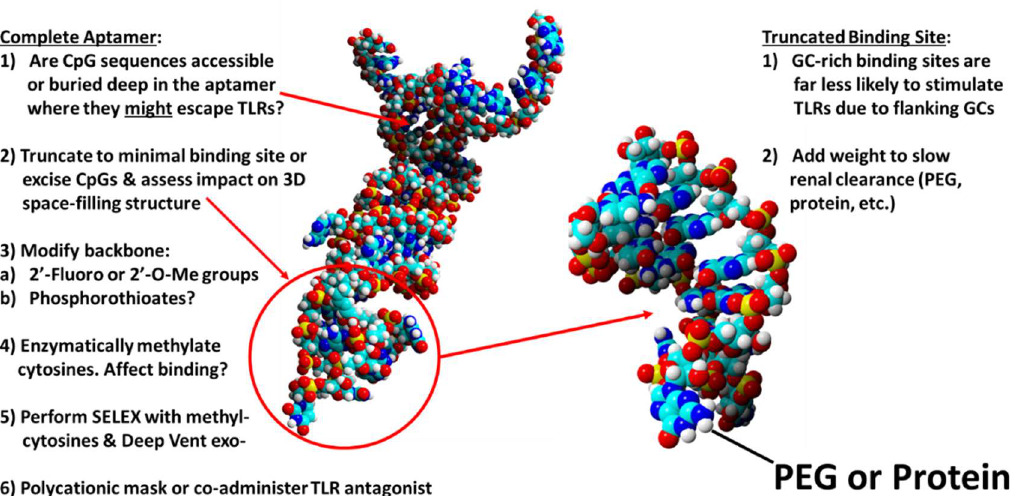
Figure 2. Three-dimensional (3-D) space-filling models of one of the author’s developed aptamers using YASARA [21] to analyze the accessibility of potentially inflammatory CpG sequences and alterations to the 3-D structure of the putative binding site ( left ) once it is excised from the complete aptamer ( right ). The figure also summarizes a list of approaches to evaluating and rectifying potential CpG toxicity problems. PEG = polyethylene